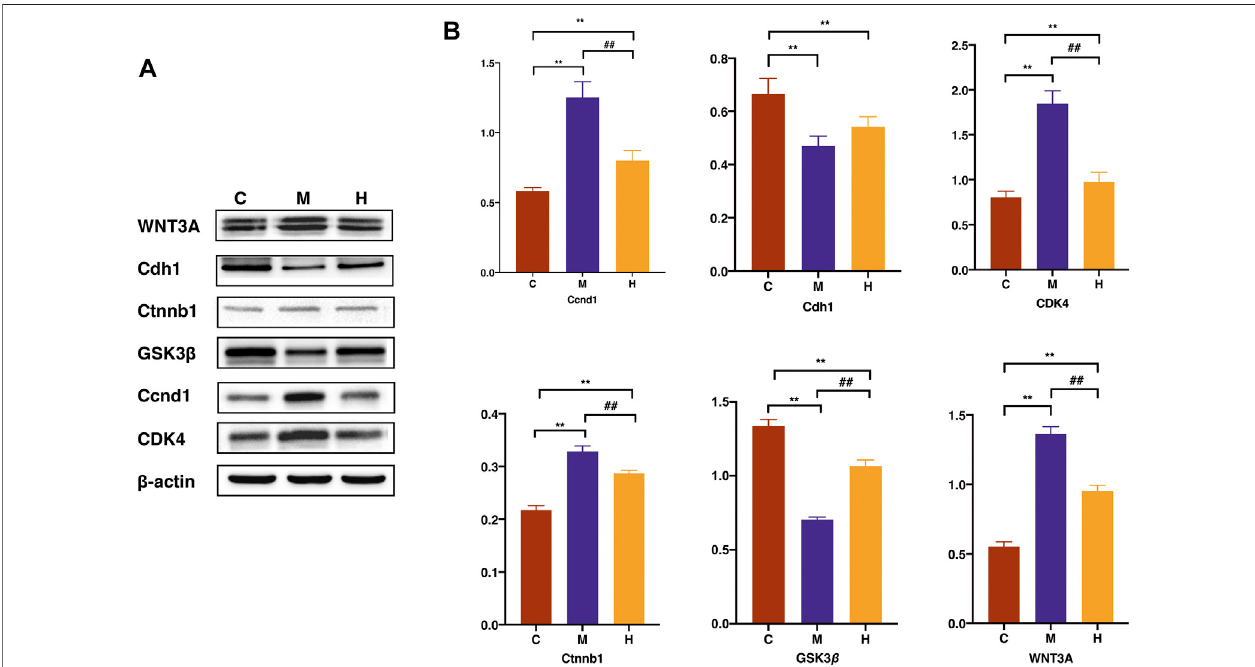
FIGURE10| Effects ofHQT on differential protein expression in CAC mice. (A) Western blot analysisof WNT3A 、 Cdh1 、 Ctnnb1 、 GSK3 β 、 Ccnd1 and CDK4 in mice colon tissues. (B) Statistical analysis of WNT3A 、 Cdh1 、 Ctnnb1 、 GSK3 β 、 Ccnd1 and CDK4 gray values. Data are represented as the mean±SD ( n = 3, (cid:1)